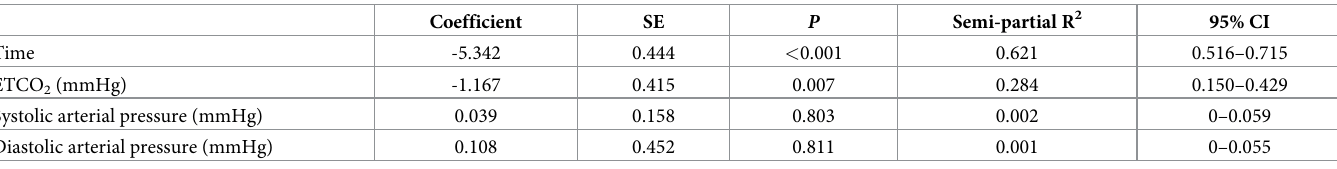
Table 6. Fixed effects of time, systolic arterial pressure, diastolic arterial pressure, and ETCO 2 level on %EDV in mixed effect model including all these hemody- namic